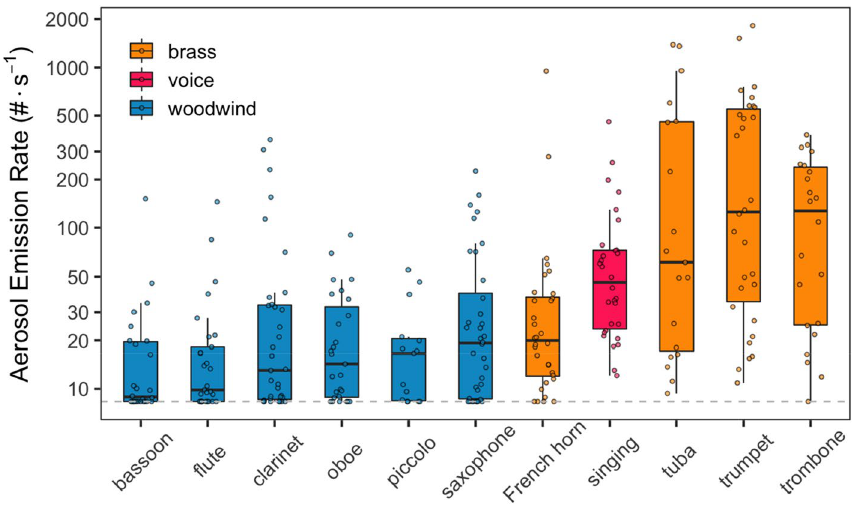
Figure 1. Boxplots of aerosol number emission rates (0.25–35.15 μm size range) by instrument class and type, including vocalists. Instruments are ordered by median emission rate with participant data as open circles; boxes delineate the inter-quartile range (IQR) and whiskers extend to 1.5 ⋅ IQR or the data minimum. The